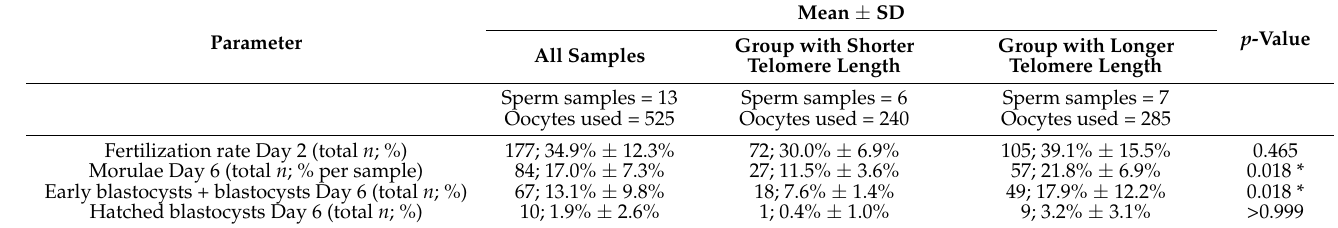
Table 3. In vitro fertilization outcomes for all analyzed samples, and for samples classified into two groups based on their telomere length (shorter or longer than the median); total n indicates the total number of embryos including all samples, % represents the average percentage of the parameter analyzed: p -values indicate statistical differences of the % between groups with shorter and longer telomere length. (*) means p ≤